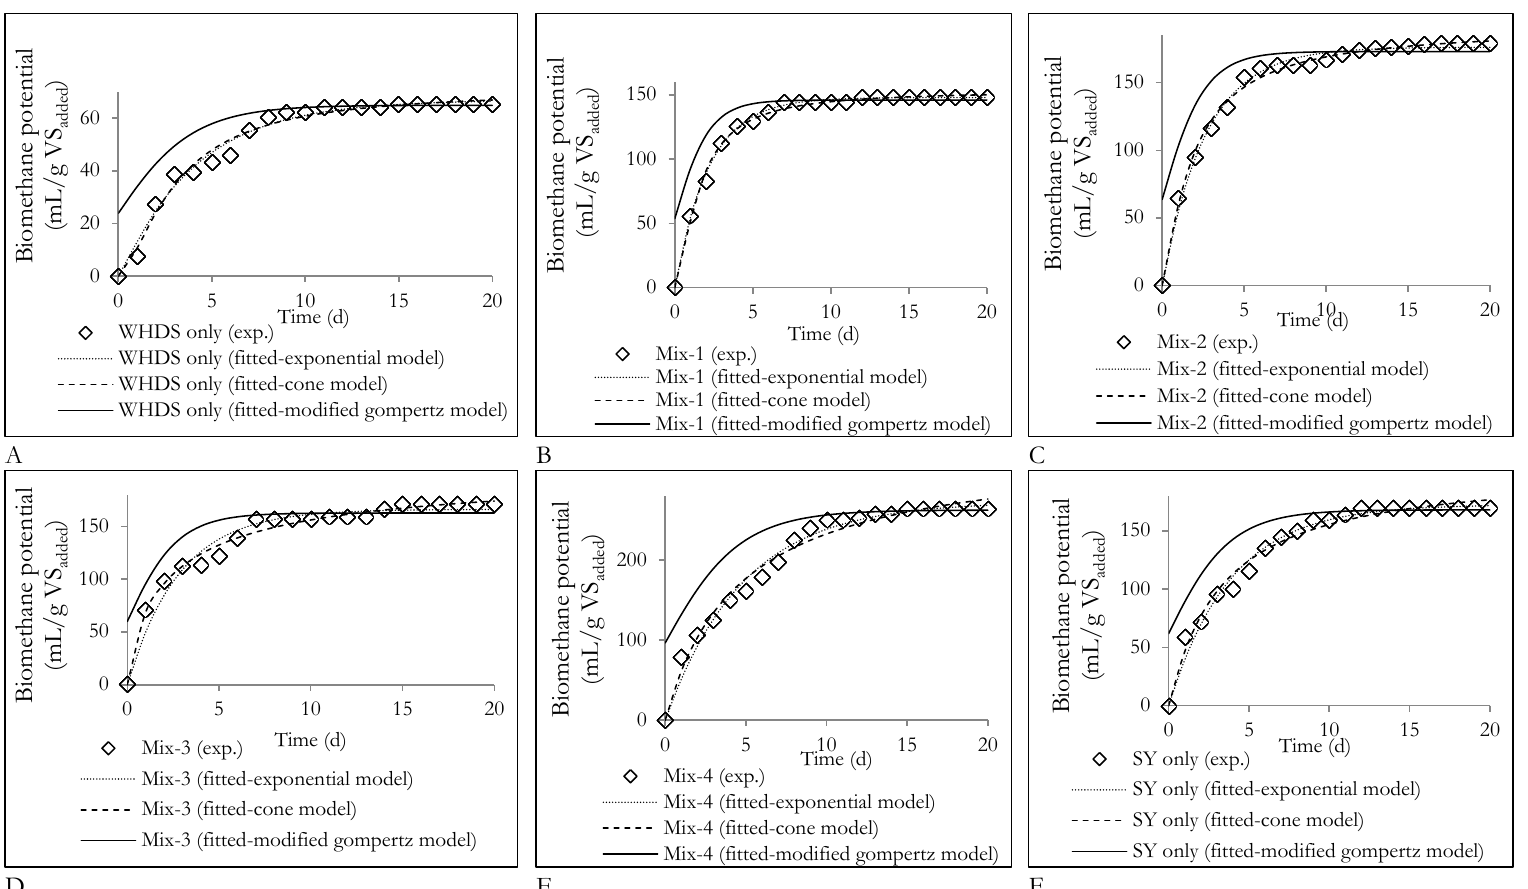
Figure 8. Fitted kinetic model curves for cumulative biomethane potentials from the anaerobic digestion of different substrates; ( A ): Variation of biomethane potentials of the degradation of the substrate of WHDS (wet hydrolyzed DAF sludge) only with time; ( B ): Variation of biomethane potentials of the degradation of the substrate of Mix-1 with time; ( C ): Variation of biomethane potentials of the degradation of the substrate of Mix-2 with time; ( D ): Variation of biomethane potentials of the degradation of the substrate of Mix-3 with time; ( E ): Variation of biomethane potentials of the degradation of the substrate of Mix-4 with time; ( F ): Variation of biomethane potentials of the degradation of the substrate of stockyard (SY) only with time.